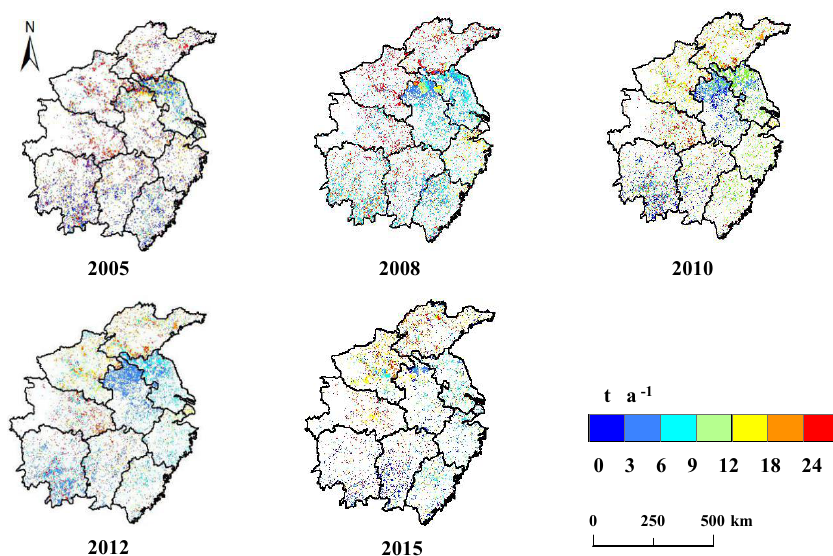
Figure 10. Annual spatial distribution (1km × 1km) of PM 2 . 5 emissions from opening biomass burning in central and eastern China.